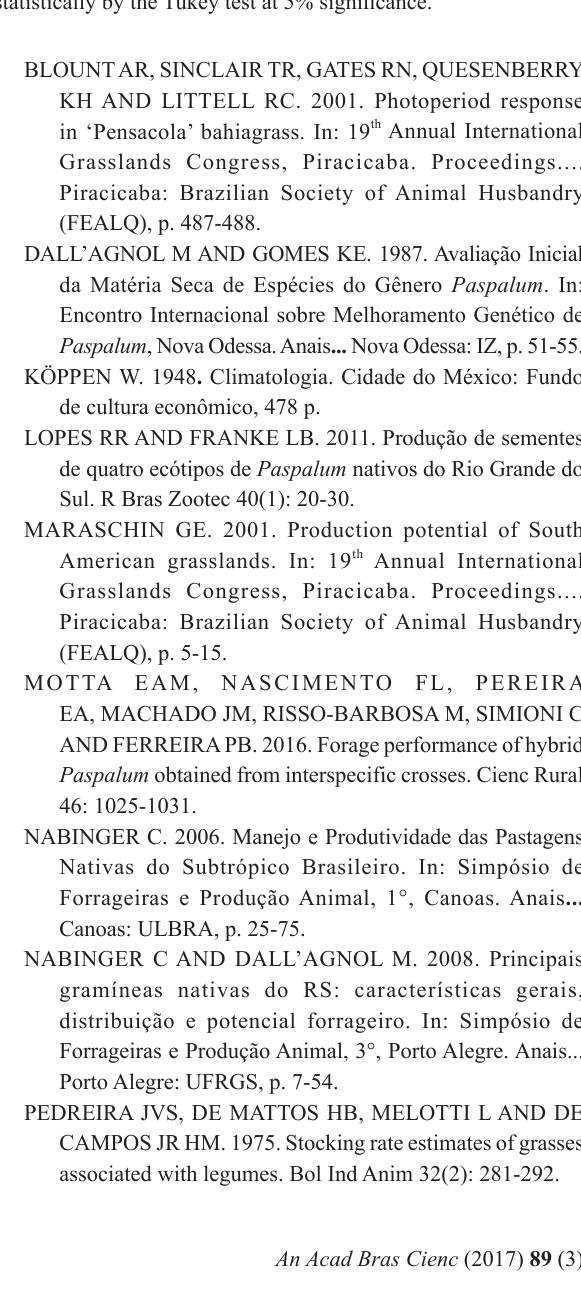
* Means followed by the same letter in the column do not differ statistically by the Tukey test at 5%